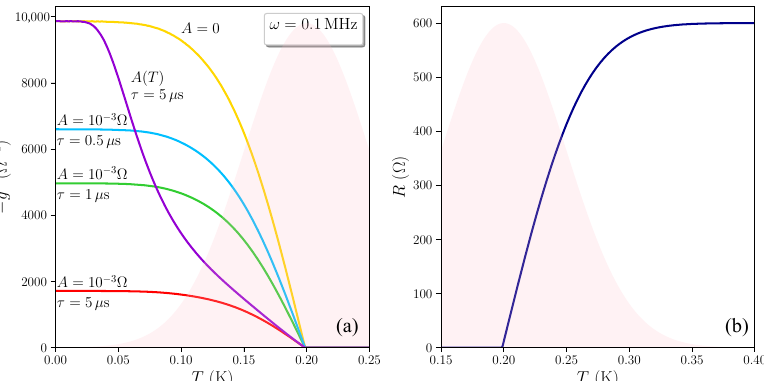
g (cid:48)(cid:48) , as a −